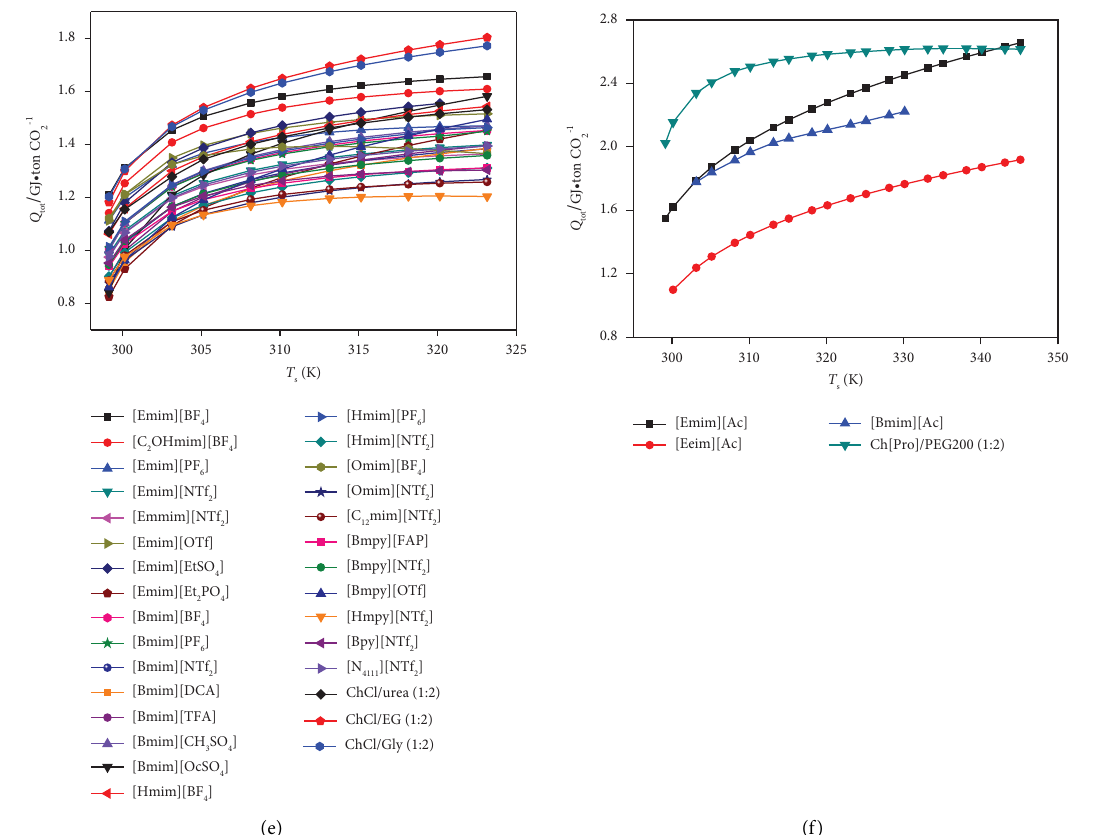
Figure 7: Te energy consumption of (a) 30 physical absorbents for efuent gases, (b) 4 chemical absorbents for efuent gases, (c) 30 physical absorbents for kiln gas, (d) 4 chemical absorbents for kiln gas, (e) 30 physical absorbents for biomass syngas, and (f) 4 chemical absorbents for biomass syngas.